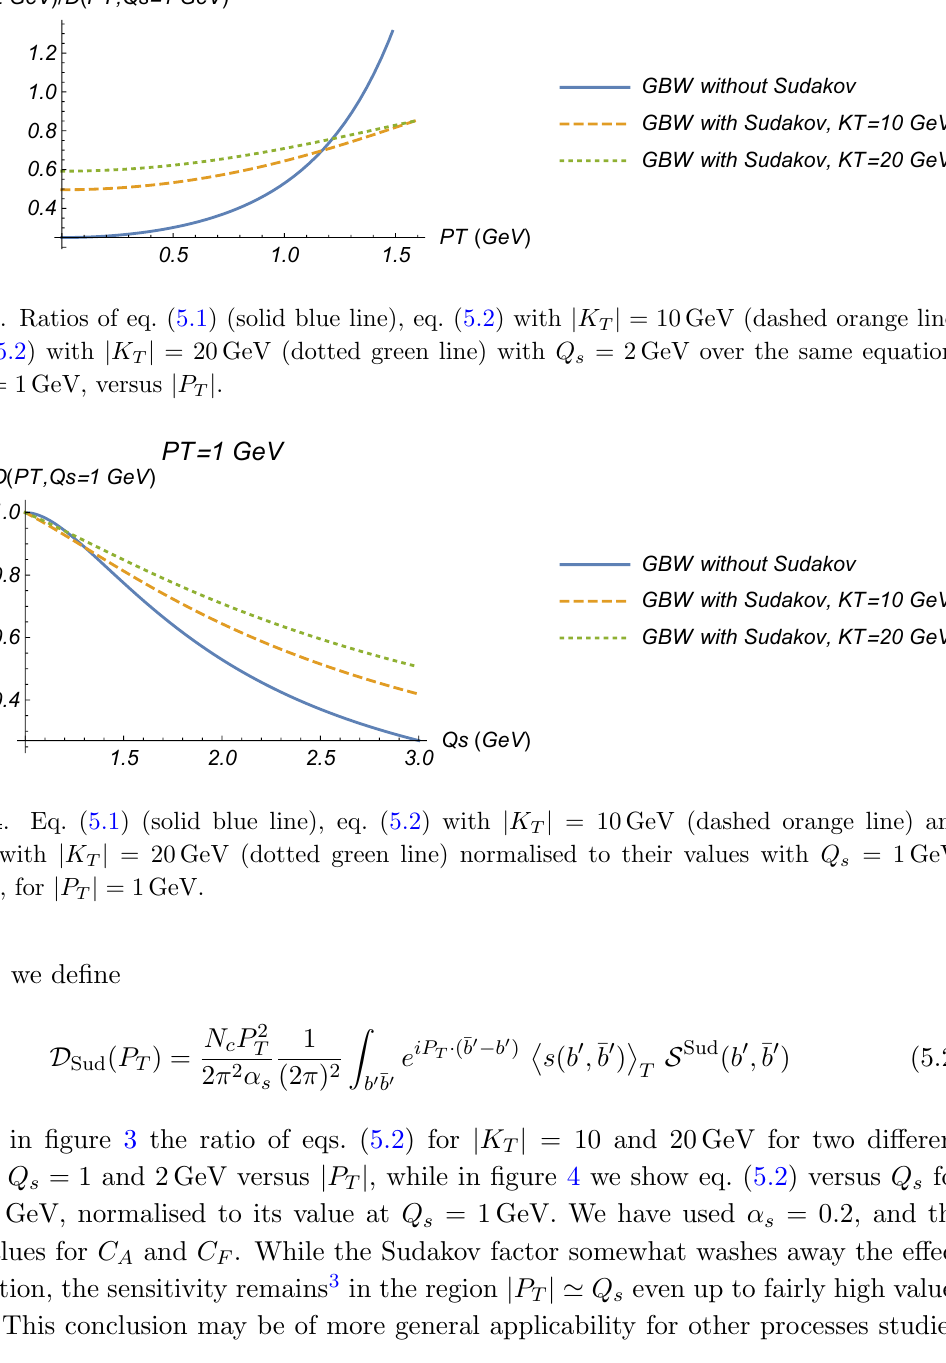
K T = 10 GeV (dashed orange line) j j